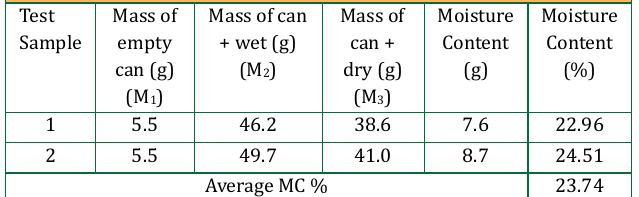
Table 2 (a): Moisture content test results for sample point 1